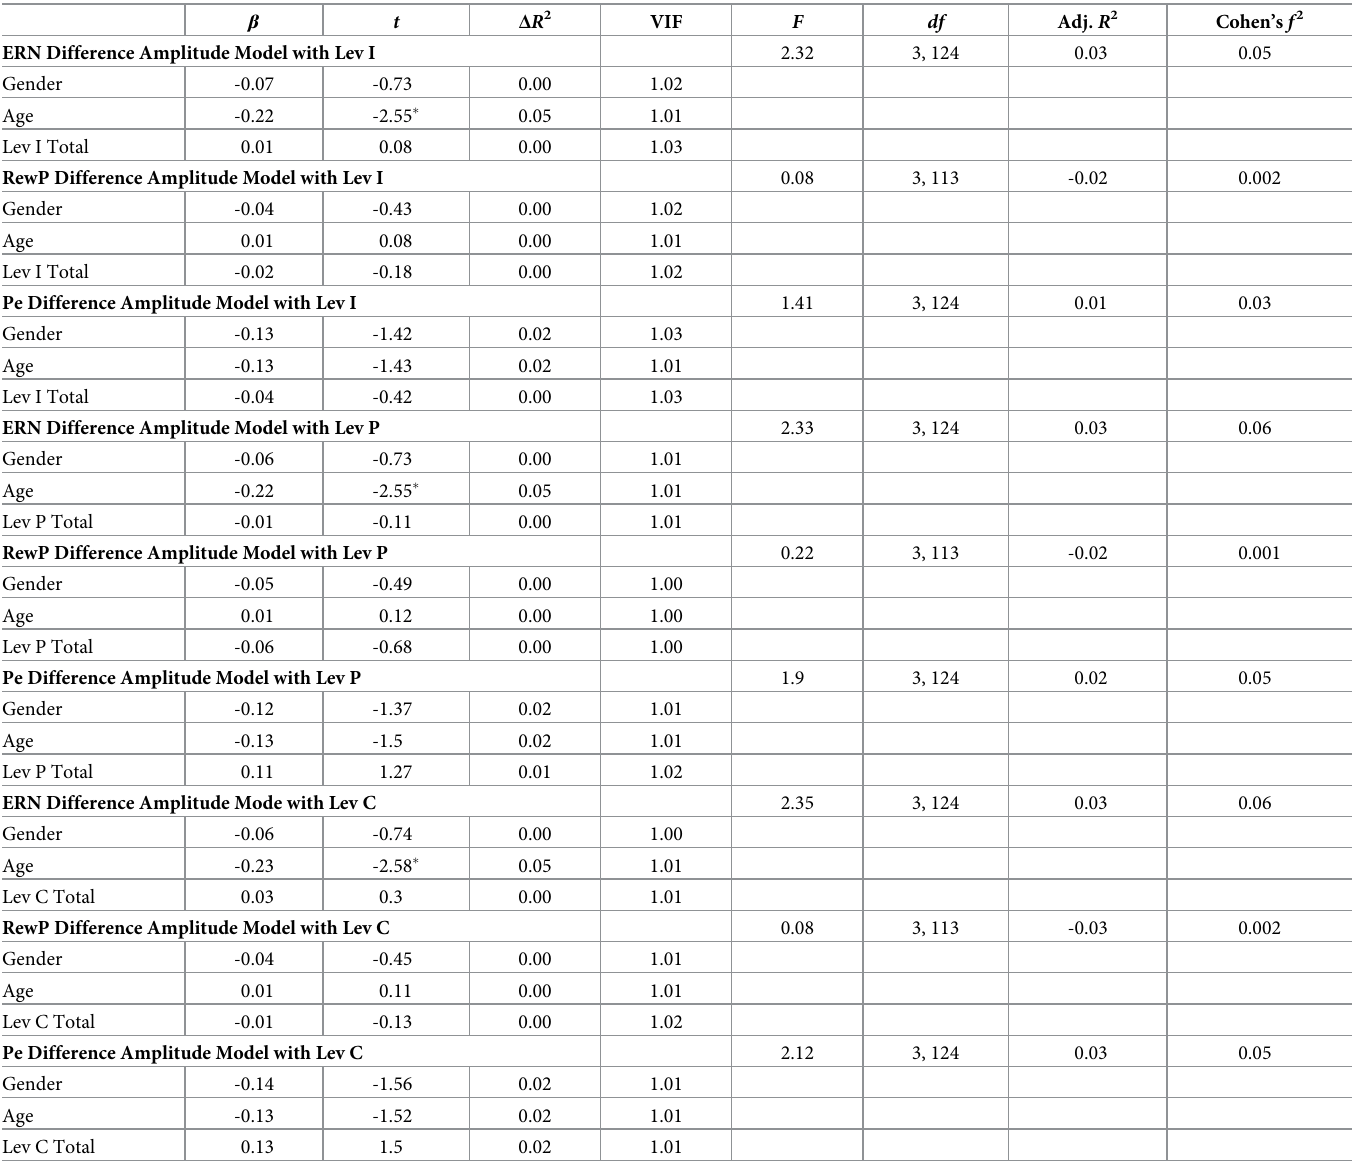
Table 4. Multiple linear regressions with Levenson subscales (locus of control) predicting difference